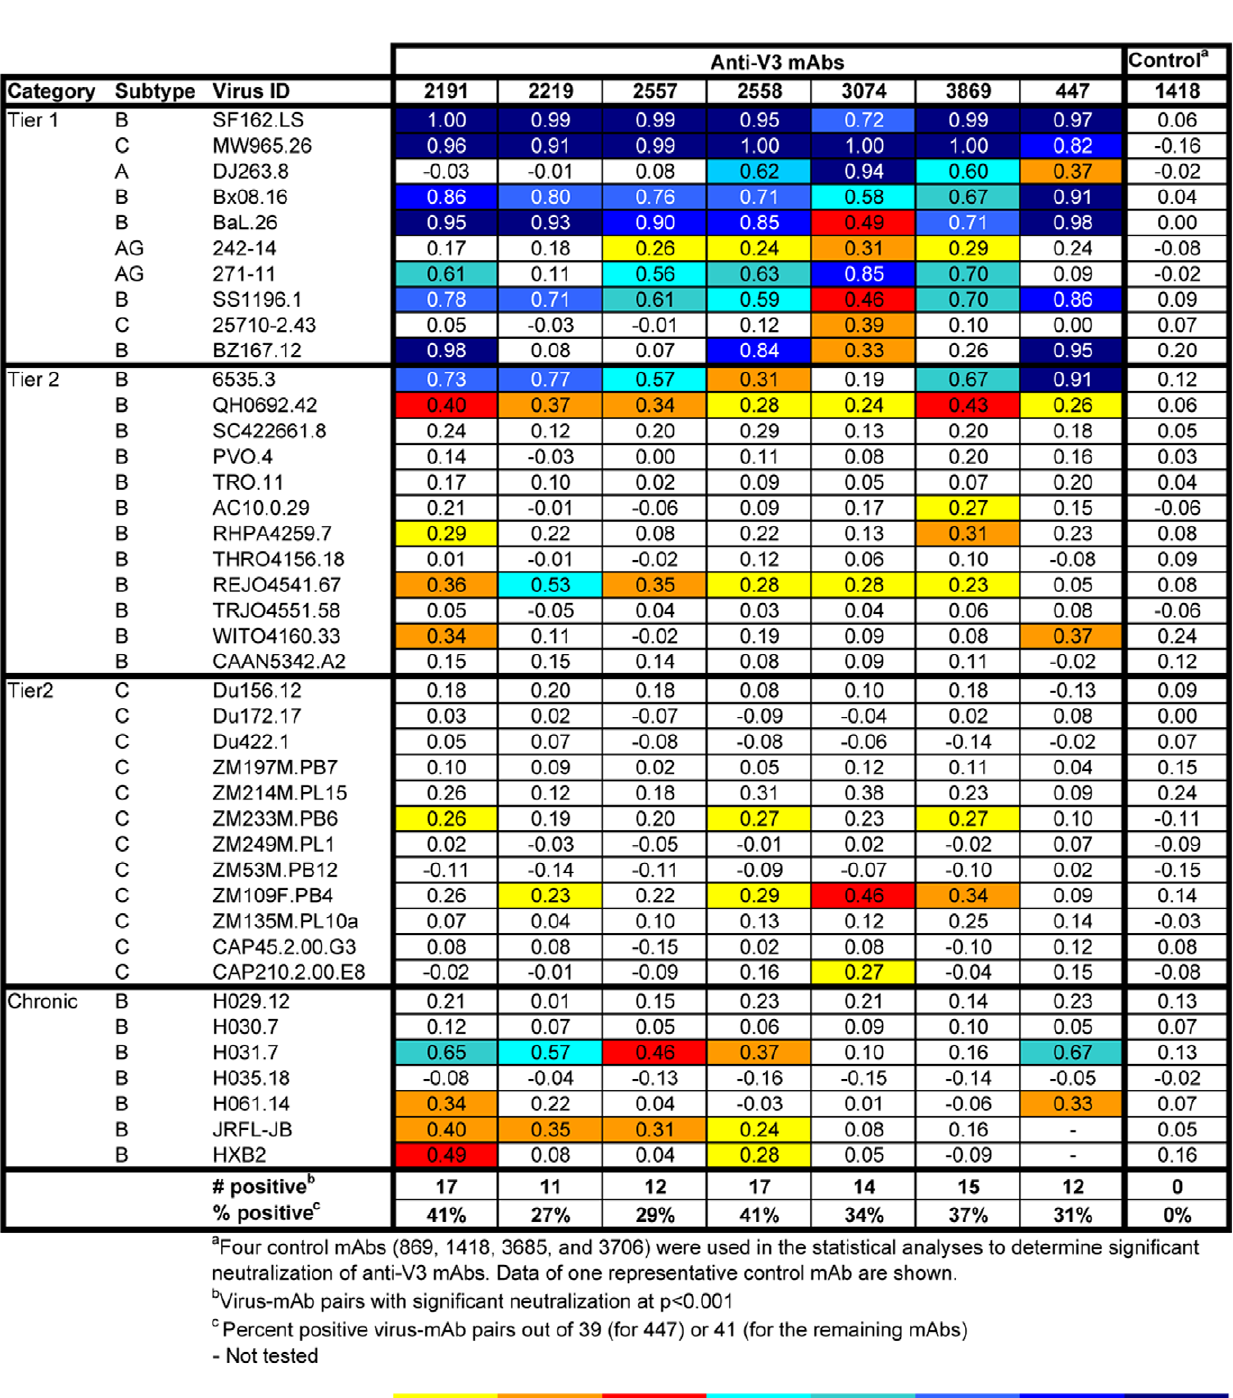
multiple subtypes derived from patients at different stages of infection. Overall, the data show that 57% of the 98 psVs tested were sensitive to neutralization by one or more of the seven anti-